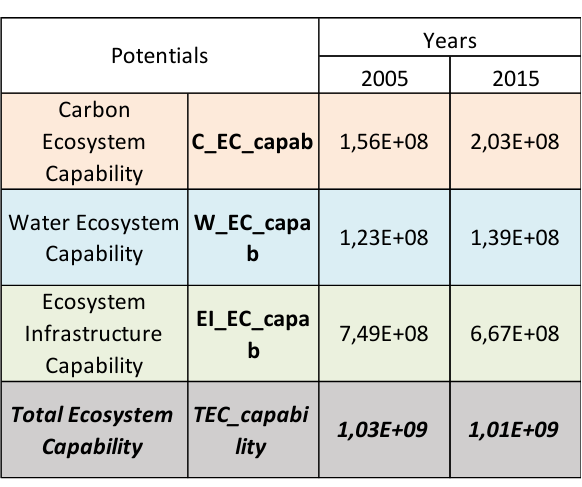
Figure 9. Soil Carbon at 1m depth (T/ha)